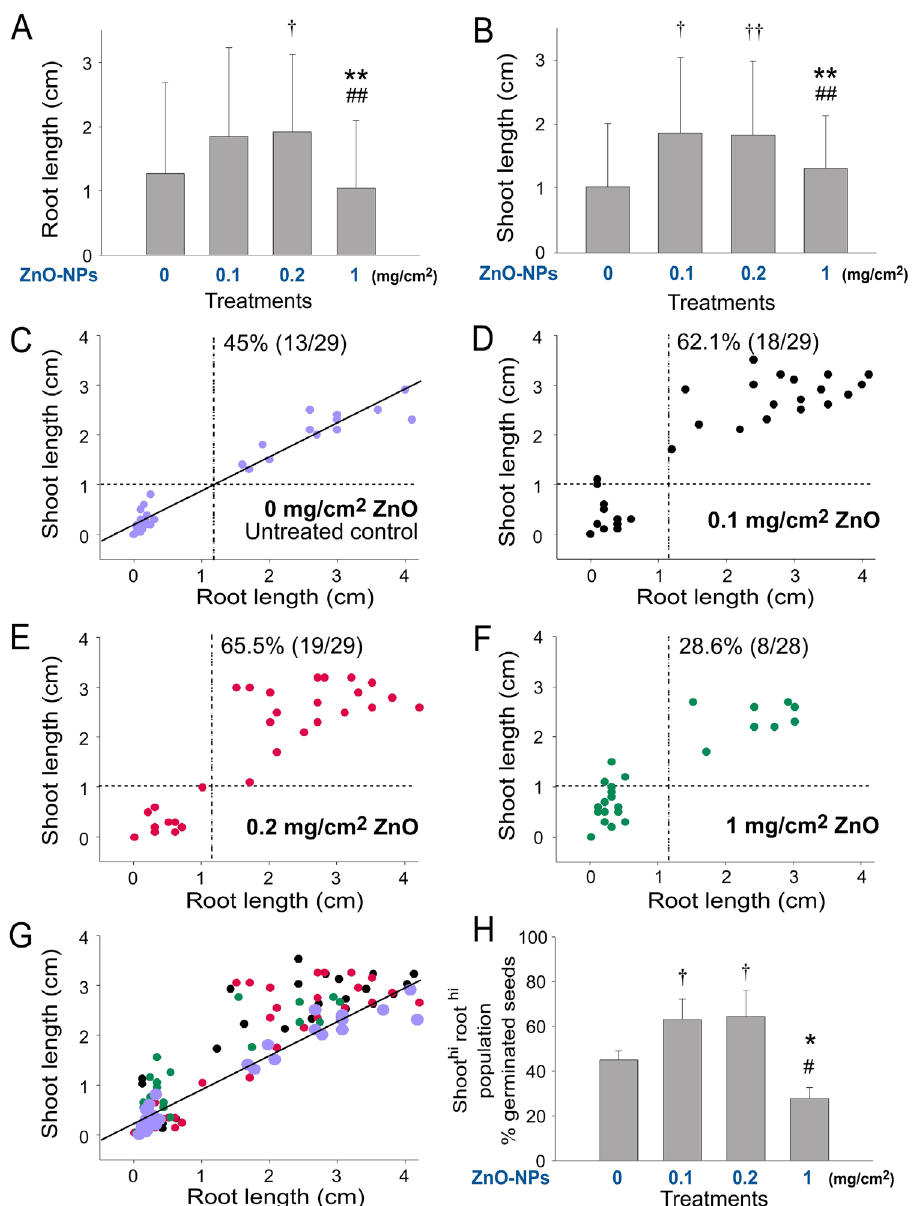
Figure 4. Soil ZnO NP levels affect the seedling growth of Amaranthus mangostanus. Analyses of root ( A ) and shoot ( B ) length of 1-week-old Amaranthus mangostanus seedlings. Root–shoot 2D graphs of the seedling without ( C ) and with different doses of ZnO NP treatments ( D–F ), and an overlay ( G ) are shown. The regression lines of untreated groups were indicated ( C,G ). The shoot hi root hi population (upper-right quadrant) of seedlings in each condition was quantified ( H ). The vertical and horizontal dotted lines in ( C–F ) are the mean values of root length and shoot length of the untreated control groups ( C ), respectively. † P < 0.05, †† P < 0.01, * P < 0.05, ** P < 0.01 vs. 0 mg/cm 2 ZnO untreated groups; # P < 0.05, ## P < 0.01 vs. respective 0.2 mg/cm 2 ZnO groups. n = 90 (3 independent experiments; each experiment with 30 seeds) ( A,B ). n = 30 (3 independent experiments; each experiment with 10 seeds) (C–G). n = 3 (3 independent experiments; each experiment with 30 seeds) ( H